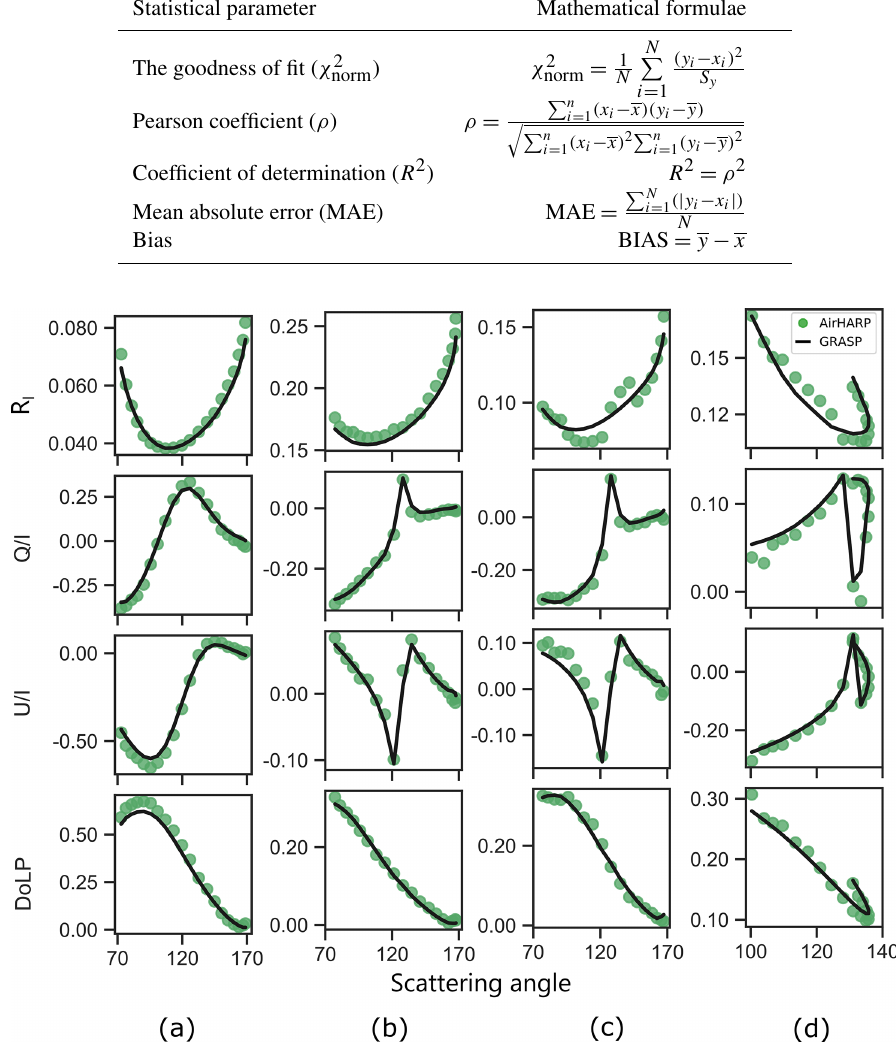
Figure 7. AirHARP-measured R I , Q/I , U/I , and DoLP (solid colored circles) and the GRASP fit (black solid lines) for selected pixels from the scene in Fig. 4a–c are plotted for the 550nm band. Column (a) is an offglint pixel from the scene on 23 October 2017 T21:30UTC; (b) for a dry lake pixel from the flight leg on 25 October 2017 T18:26UTC; (c) for a vegetation surface also from the flight leg on 25 October 2017 T18:26UTC; (d) for a smoke pixel from the flight leg on 27 October 2017